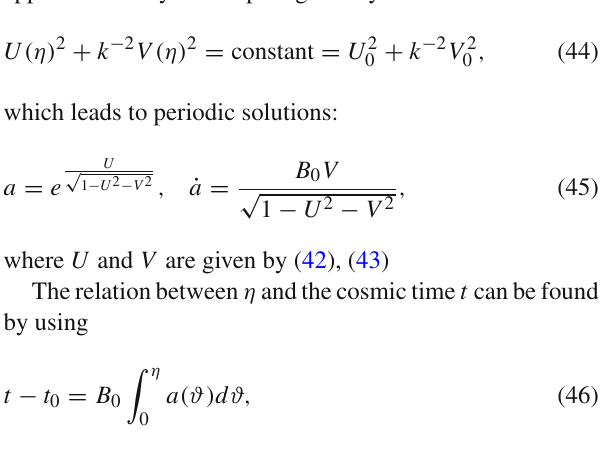
Fig. 8 Behaviorofthescalefactoranditsfirstderivativeintermsofthe parameter η . In the figure it is shown a typical behavior for the